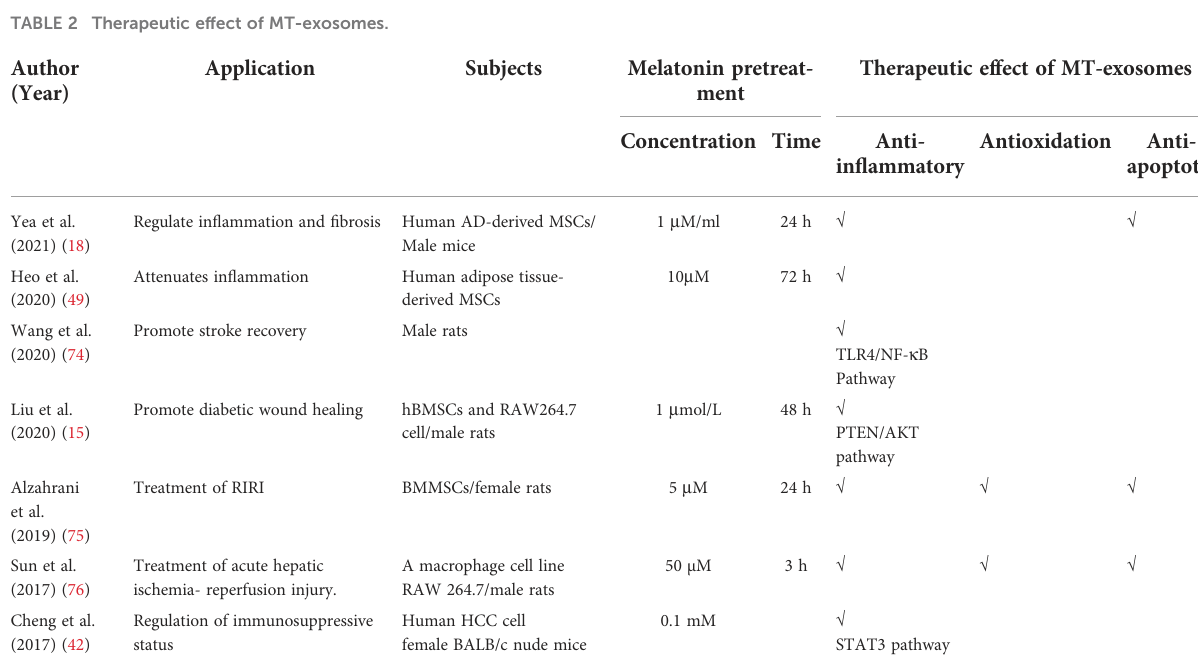
TABLE 2 Therapeutic effect of MT-exosomes.